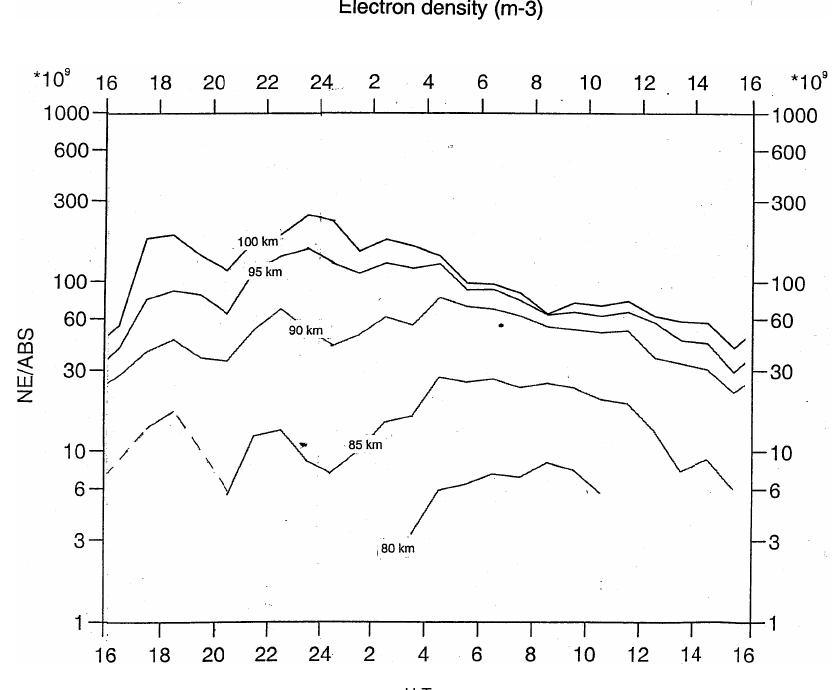
Fig. 3. Histograms of electron density from 100km to 70km.